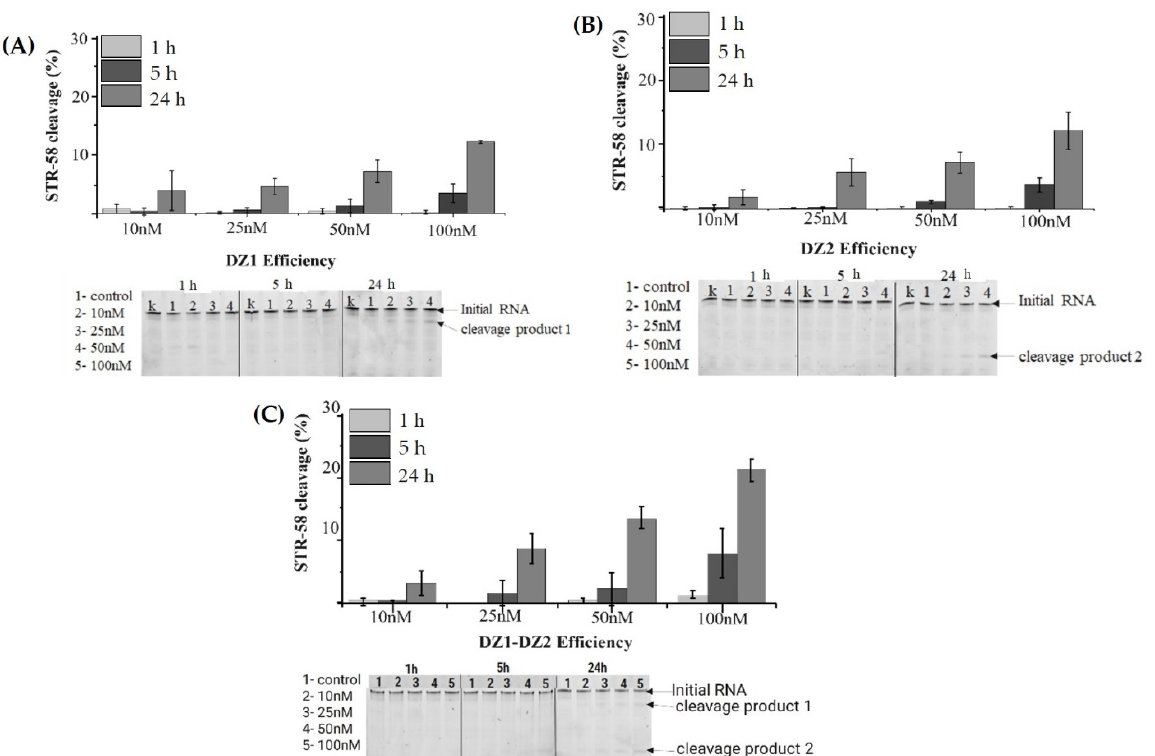
Figure 4. Relative cleavage of STR-58 RNA under multiple turnover condition. ( A ) Dz1 cleavage efficiency with STR-58 as a target. ( B ) Dz2 cleavage efficiency with STR-58 as a target. ( C ) Cleavage efficiency of Dz1-Dz2 association with STR-58 as a target. The results represent an average of at least 3 independent measurements.